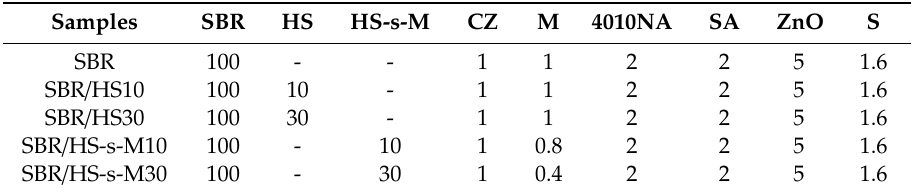
Table 1. Formulations of SBR compounds.